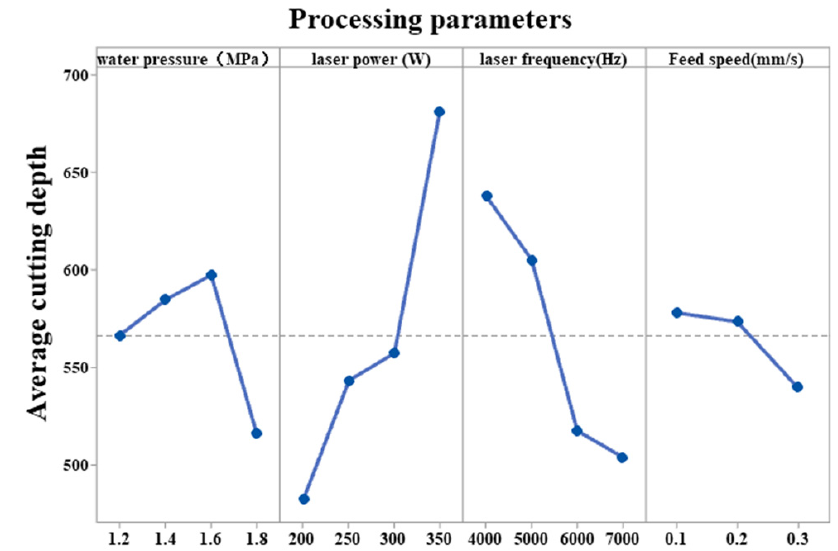
Figure 5. Main effect diagram of the mean value of cutting depth.